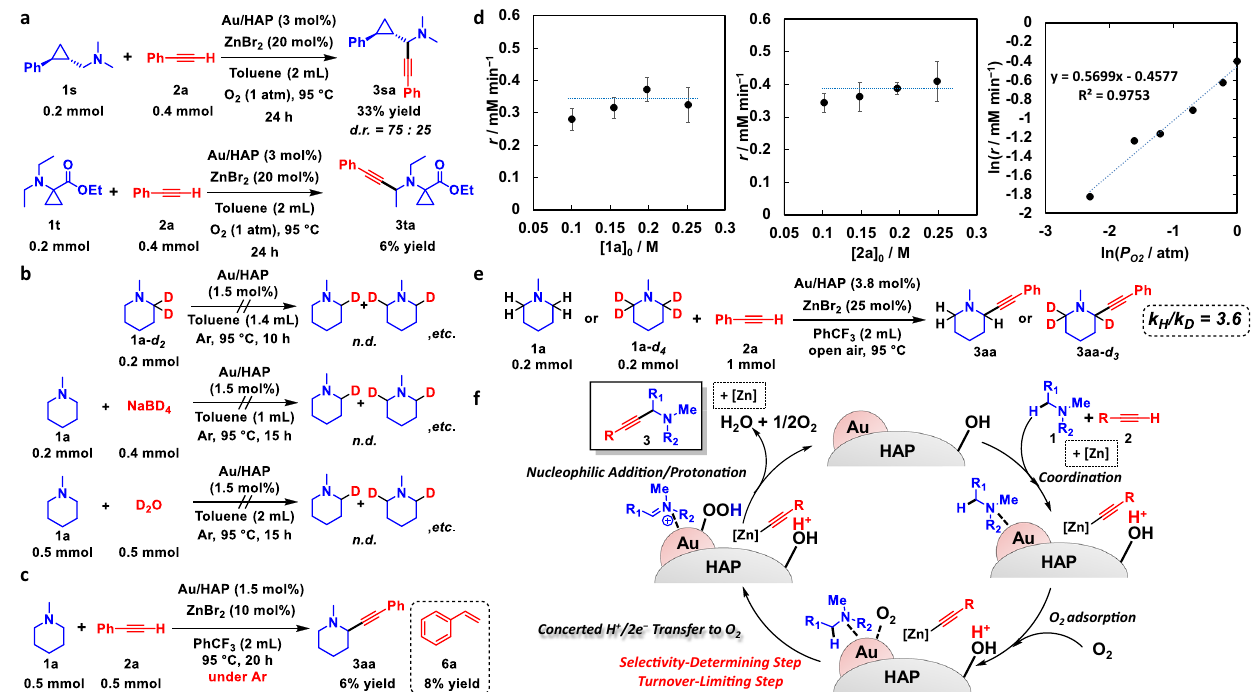
Fig. 4 | Overview of the α -methylene-speci fi c alkynylation mechanism. a Alkynylation of radical clocks ( 1s or 1t ) with 2a . Isolated yields are shown. b Scramblingofdeuteriumusing 1a- d 2 , 1a andNaBD 4 or 1a andD 2 O. c Alkynylation of 1a with 2a under Ar. GC yields are shown. d Dependence of the 3aa production rateontheconcentrationof 1a ,theconcentrationof 2a andtheO 2 partialpressure.